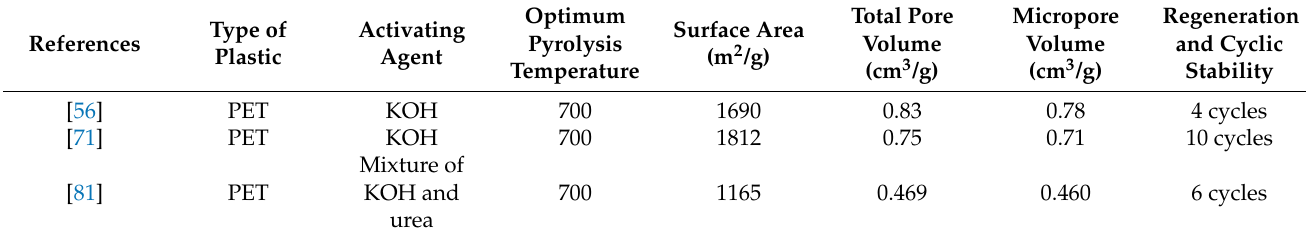
Table 5. Textural properties of chars derived from plastic pyrolysis.